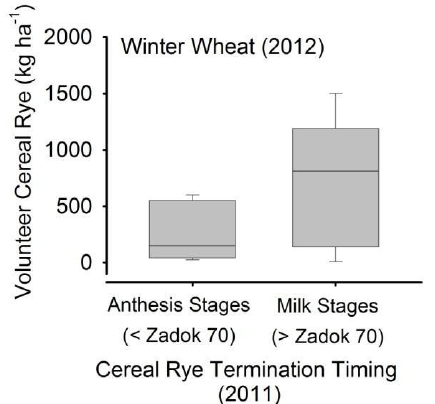
Figure 2. Effect of cereal rye termination timing in 2011 on volunteer cereal rye abundance in the following winter wheat cash crop (2012) at the Pennsylvania and Maryland locations (data from the Reduced ‐ tillage Organic Systems Experiment (ROSE)). Cereal rye termination ranged from the onset of anthesis (Zadoks 59) to the soft dough stage (Zadoks 85).